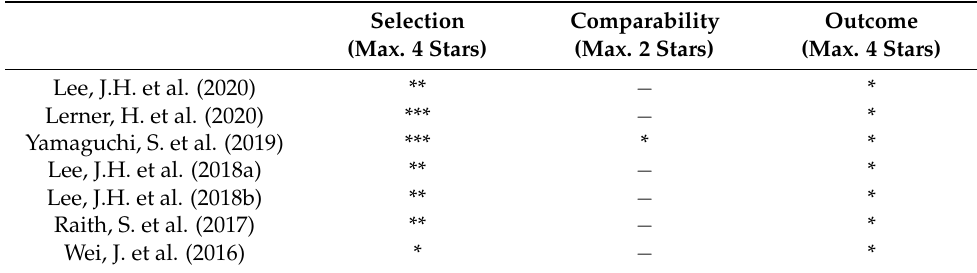
Table 2. Presentation of risk of bias evaluation for included